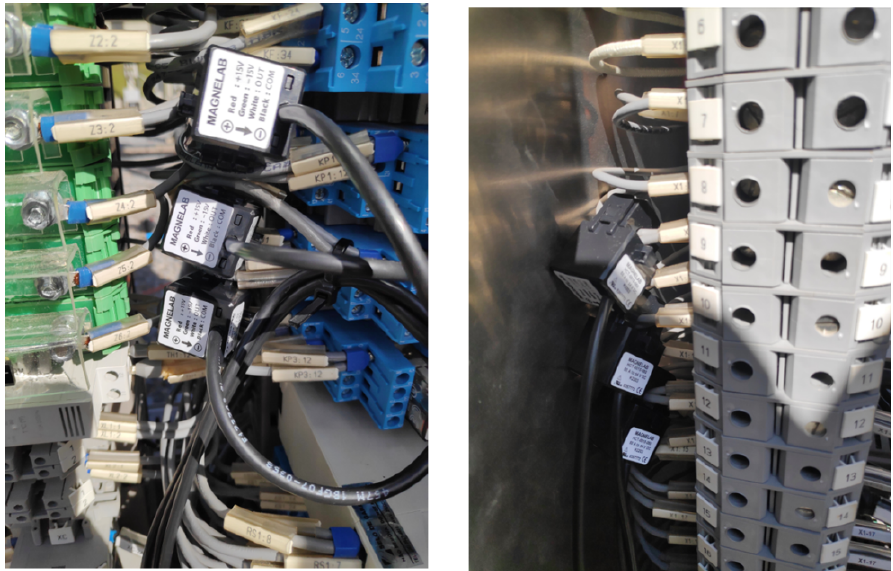
Figure 20. Hall-type clamp on current transducers installed in the HVCB synchronism